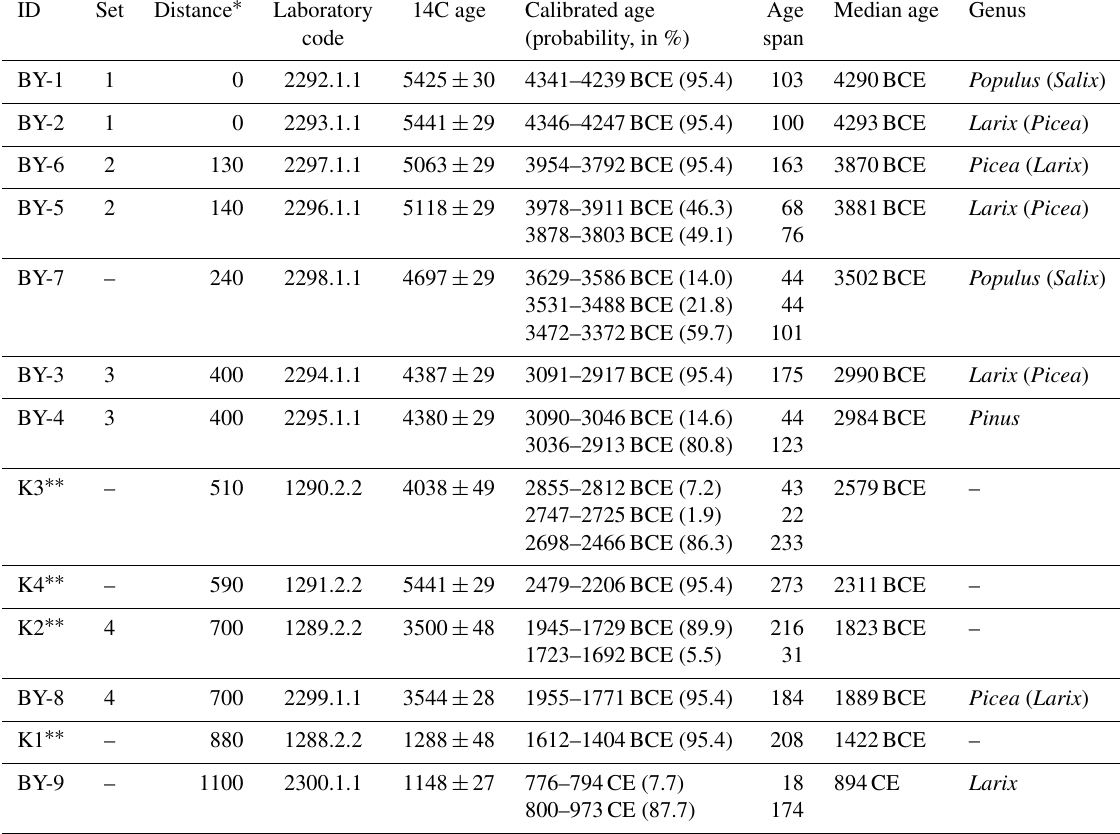
Table 1. Overview of radiocarbon samples from Bys Tasa (BY). ID